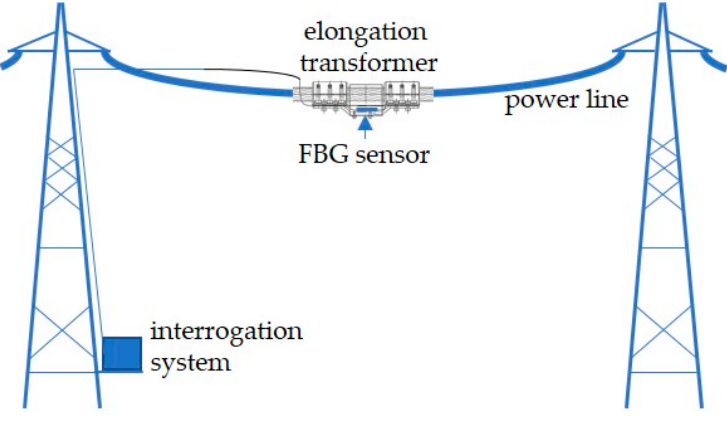
Figure 4. The overhead transmission line wire sag measurement system.